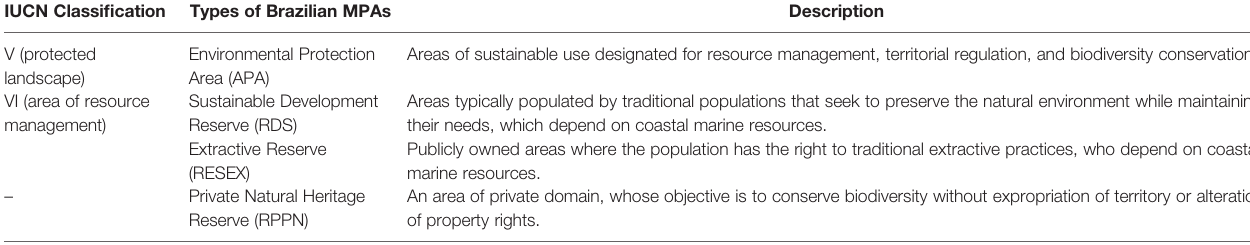
TABLE 1 | Description of the types of MPAs in Brazil analyzed in this research and correlation with the international classi fi cation by IUCN (International Union of Conservation